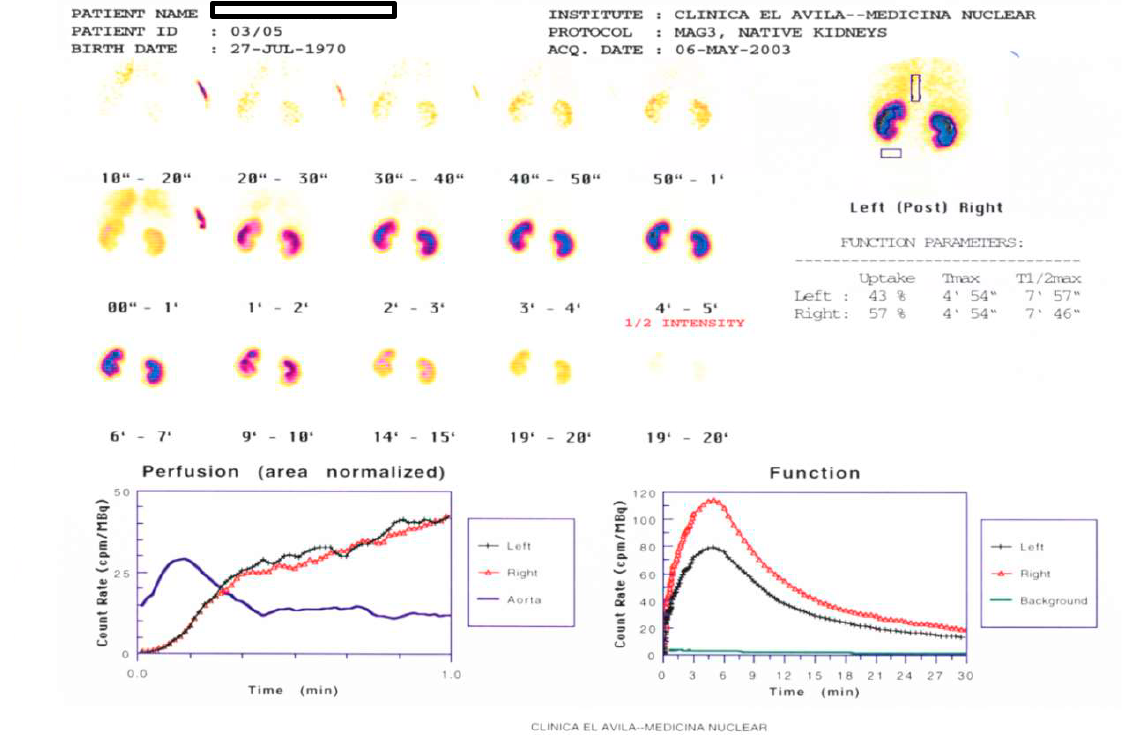
Figure 3. Static and dynamic renal scintigraphy with perfusion curve. Patient 2 Report of static and dynamic renal scintigraphy with perfusion curve (Patient 2): Good perfusion and function in both kidneys, without elimination phase lesion. Differential function: right kidney 57%, left kidney 43% (Figure 3) Renal ultrasound report (Patient 2): Both kidneys with normal form and size; right kidney: 94.2 mm x 41.8 mm, parenchyma 12.1 mm. Left kidney 112.5 mm x 62.4 mm, parenchyma 13.6 mm. No cyst nor pielocalicial